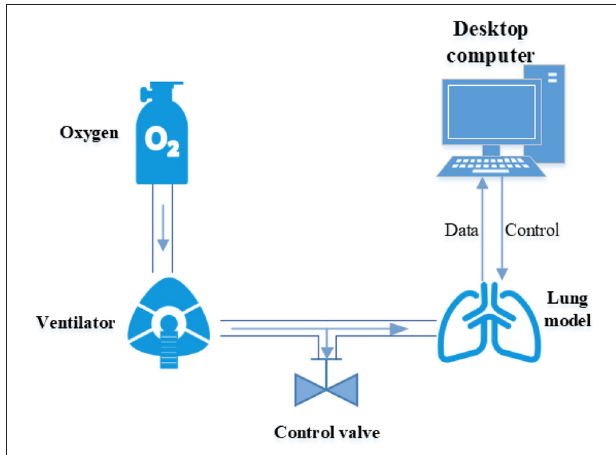
FIGURE 2 | Illustration of test hardware and